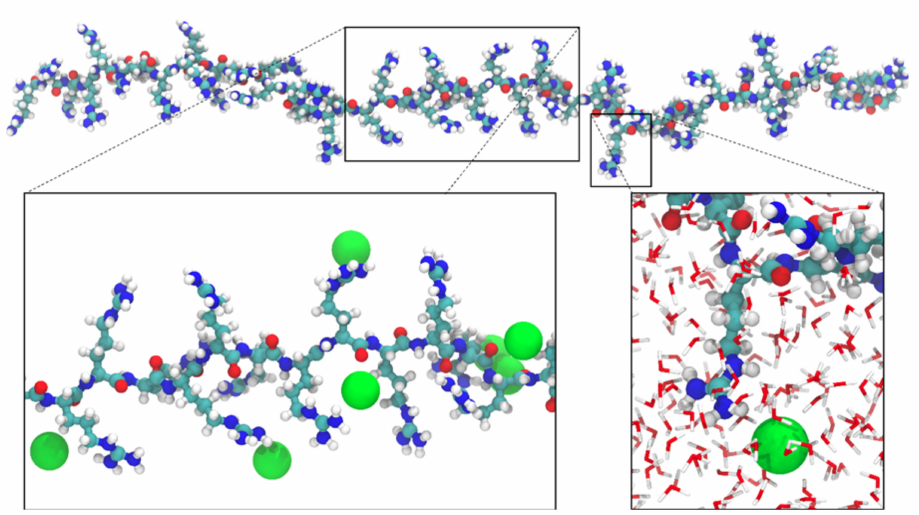
Figure 1. Snapshot of the P-Arg 50 molecule derived from MD modeling at 10 − 3 M NaCl. The Cl − ions are shown as green spheres characterized by the van der Waals radius. The N, O, C and H atoms are highlighted in blue, red, cyan and white,